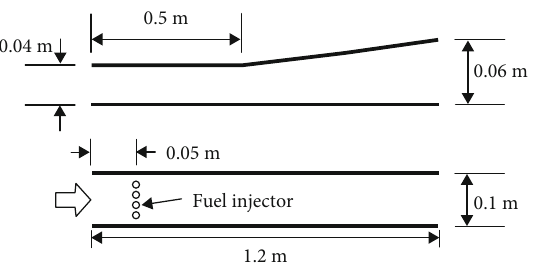
Figure 12: Geometry con fi guration of the supersonic